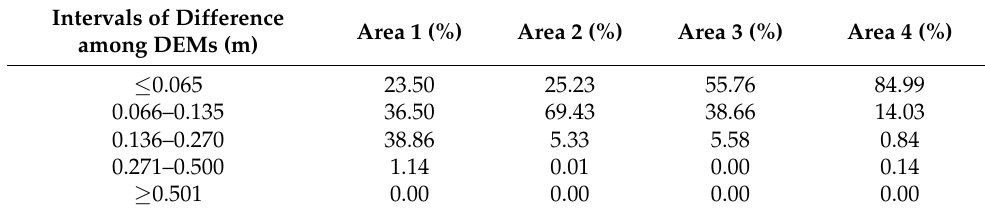
Table 1. Percentages of the differences among the DEMs in the total area. Intervals of Difference among DEMs